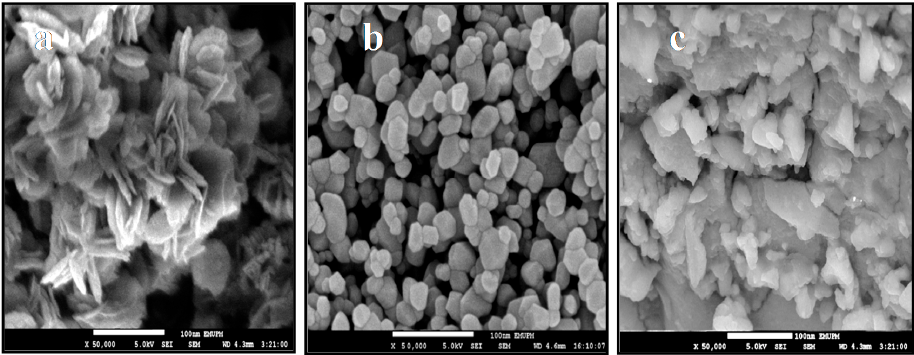
Figure 3. FESEM images of: ( a ) ZnO-F; ( b ) ZnO-S and ( c ) ZnO-P nanoparticles.